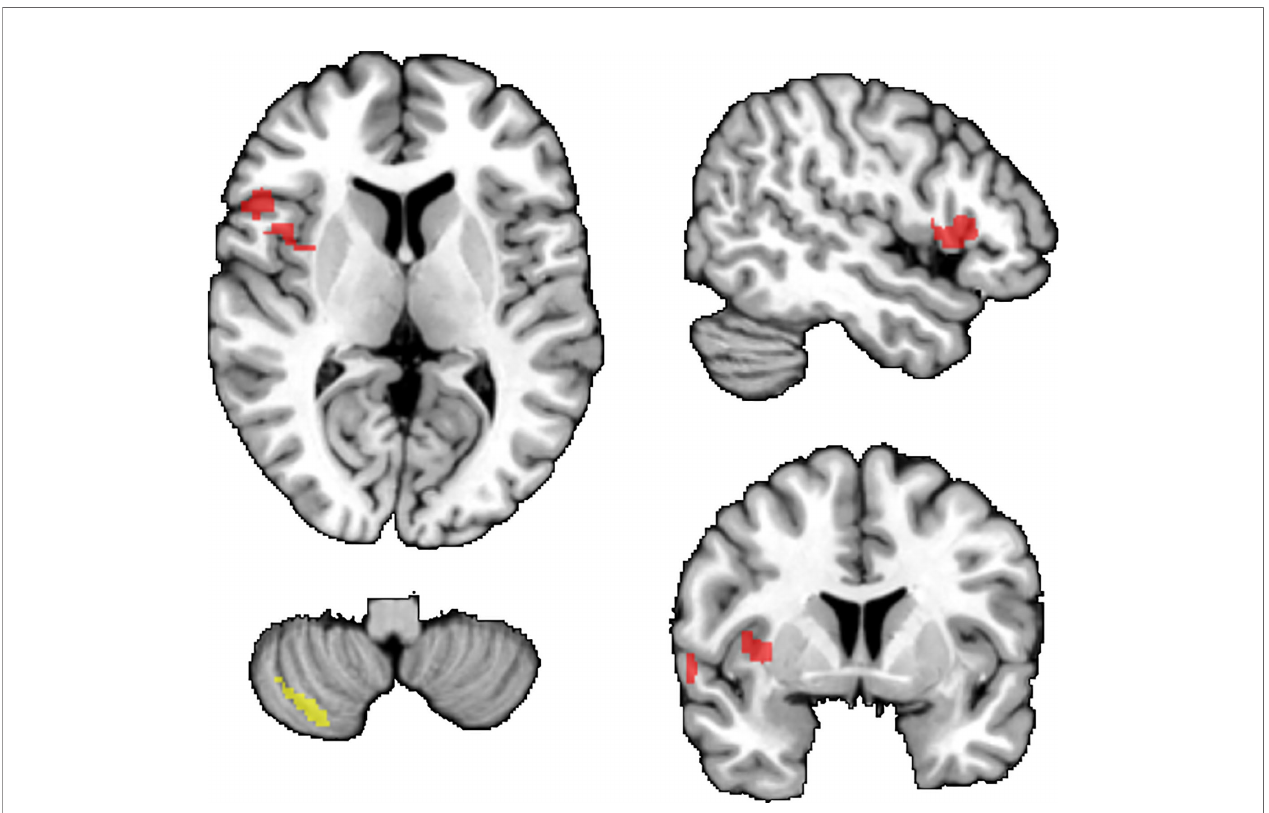
FIGURE 1 | Results of primary VBM analyses (small volume correction). Brain regions where FEP had lower GM volumes than healthy participants (red). Negative associations between BMI and GM volumes (yellow). TFCE corr. p < 0.05. Results are displayed superimposed on the Colin 27 T1